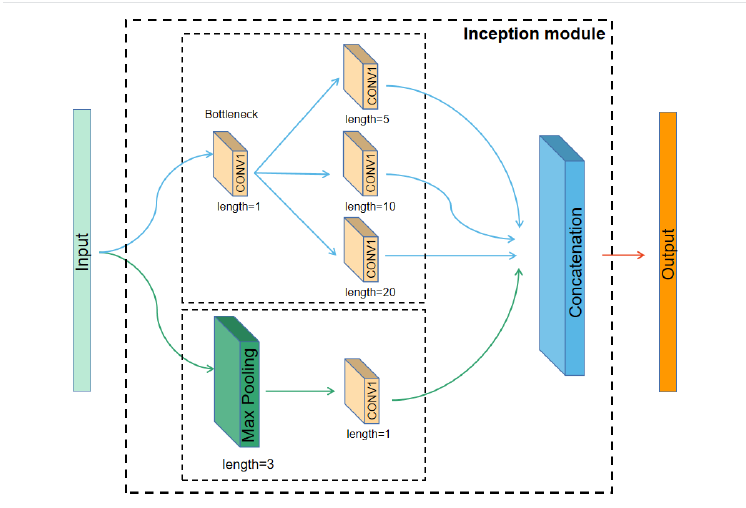
Figure 6. One-dimensional Inception